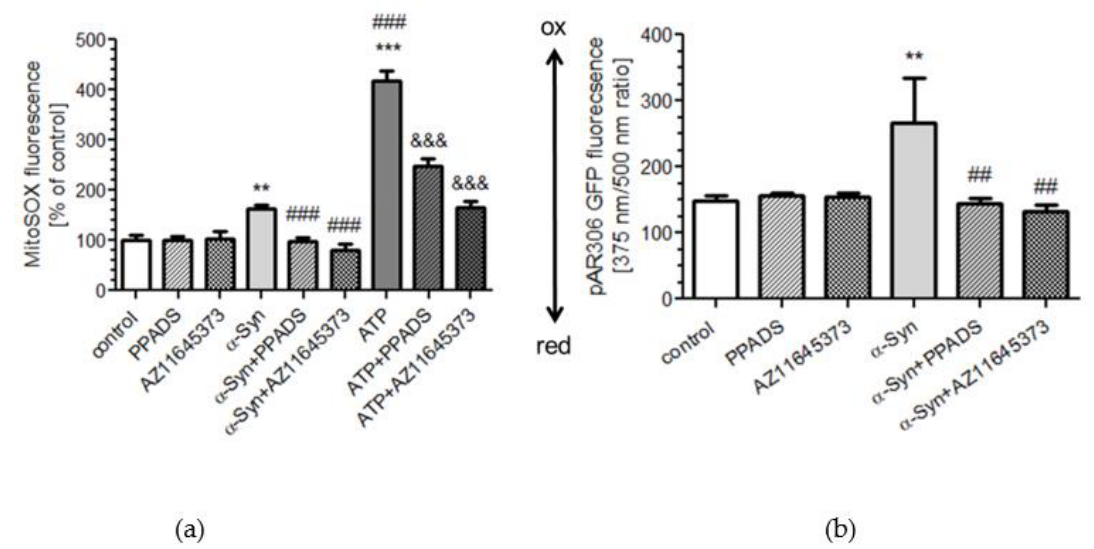
Figure 4. P2X7R activation modulates the mitochondrial redox environment in SH-SY5Y cells after α -Syn treatment. ( a ) Mitochondrial reactive oxygen species levels were measured using mitochondrial superoxide indicator (MitoSOX) after 10 µ M α -Syn or 1 mM ATP treatment for 8 h in the presence of 100 µ M PPADS or 10 µ M AZ 11645373 in SH-SY5Y cells. Data represent the mean value ± S.E.M. for four independent experiments. ** p < 0.01, *** p < 0.001 compared to control; ### p < 0.001 compared to α -Syn, and &&& p < 0.001 compared to ATP using one-way ANOVA followed by Bonferroni post hoc test. ( b ) Using a reporter gene coding for a redox-sensitive green fluorescent protein (pRA306 roGFP) located within mitochondria, the mitochondrial redox state was measured in SH-SY5Y cells after 8 h incubation with 10 µ M α -Syn in the presence of 100 µ M PPADS or 10 µ M AZ 11645373 measured by RoGFP fluorescence. Data represent the mean value ± S.E.M. for four independent experiments. ** p < 0.01 compared to control, ## p < 0.01 compared to α -Syn, using one-way ANOVA followed by Bonferroni post hoc test.